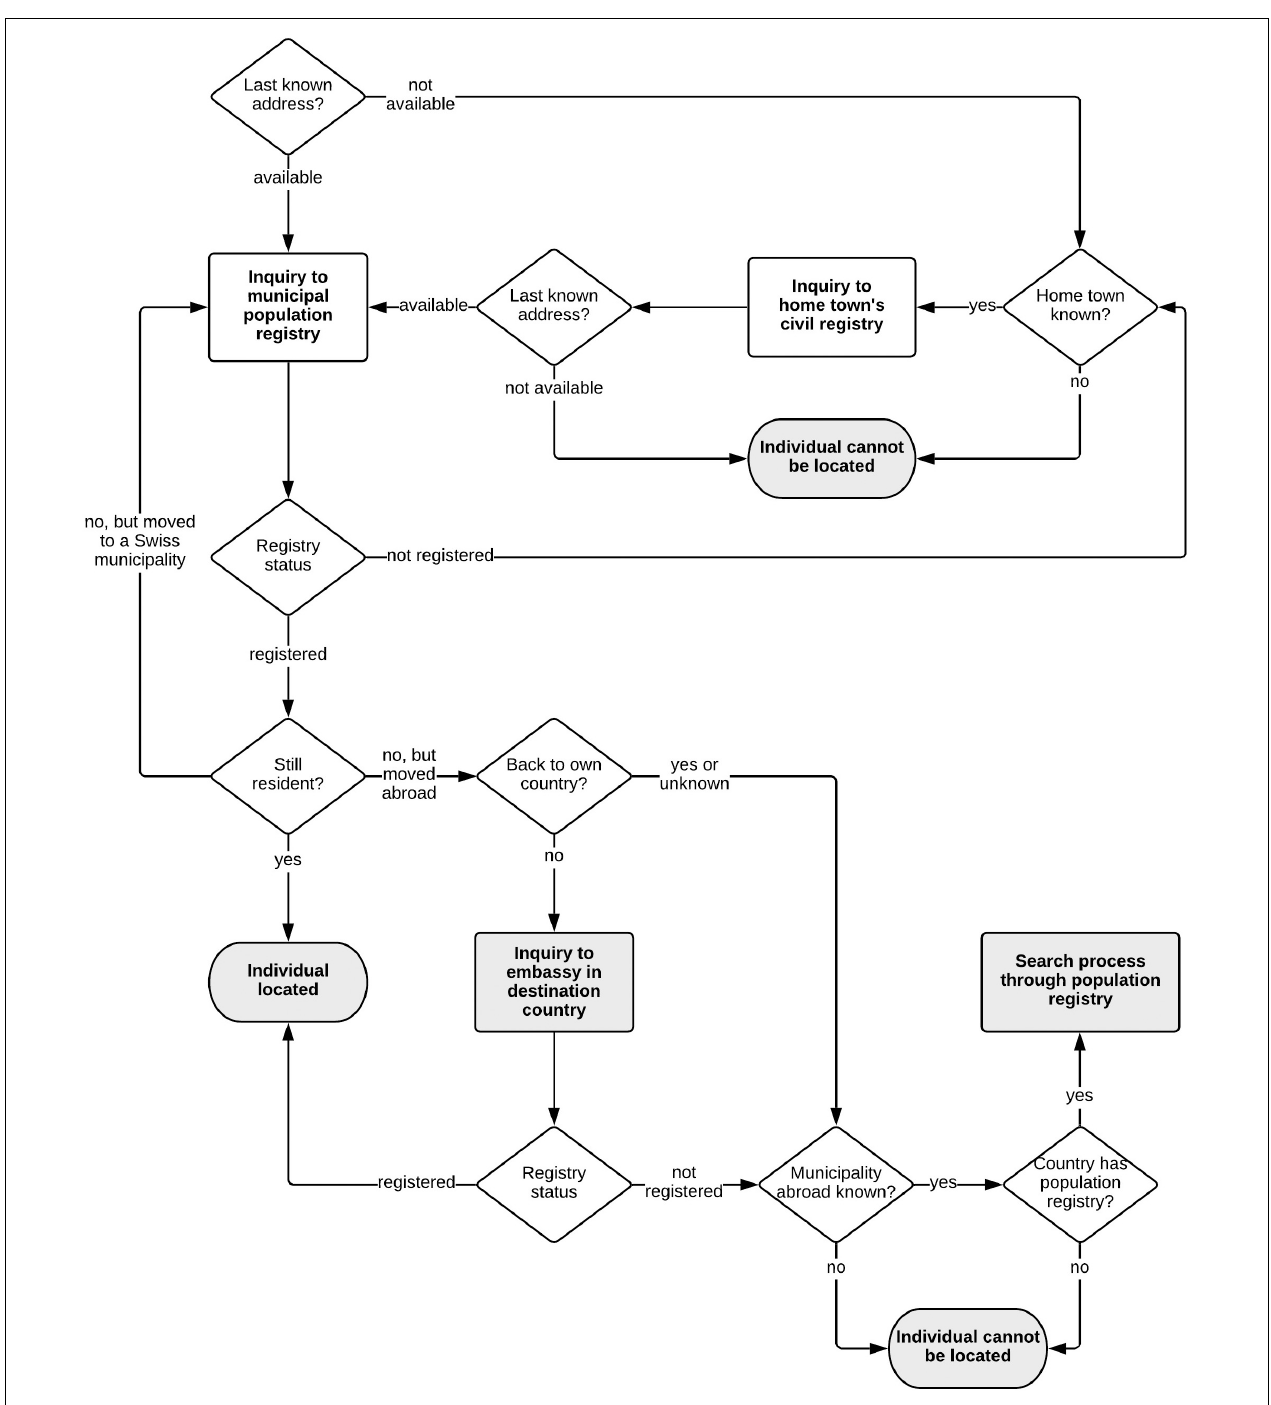
FIGURE 5 | Search process to locate